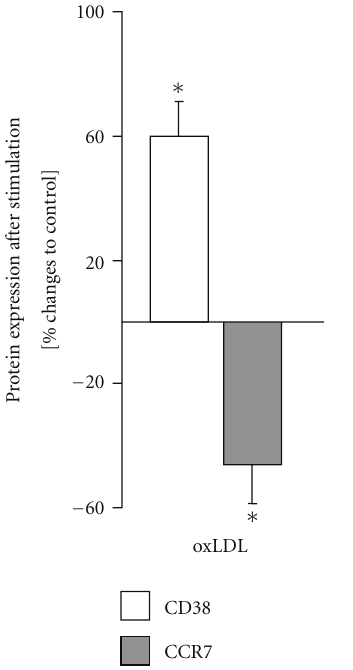
Figure 3: Protein expression of CD83 and CCR7 on DCs after stimulation with oxLDL. An increase of the expression of CD83 and a decrease of the expression of CCR7on DCs after stimulation with oxLDL (10 μ g/mL) was observed. Positive cells were measured by flow cytometry and the percent (%) changes were plotted in the figure. ∗ P < 0 . 05, ( n = 8) versus unstimulated controls.